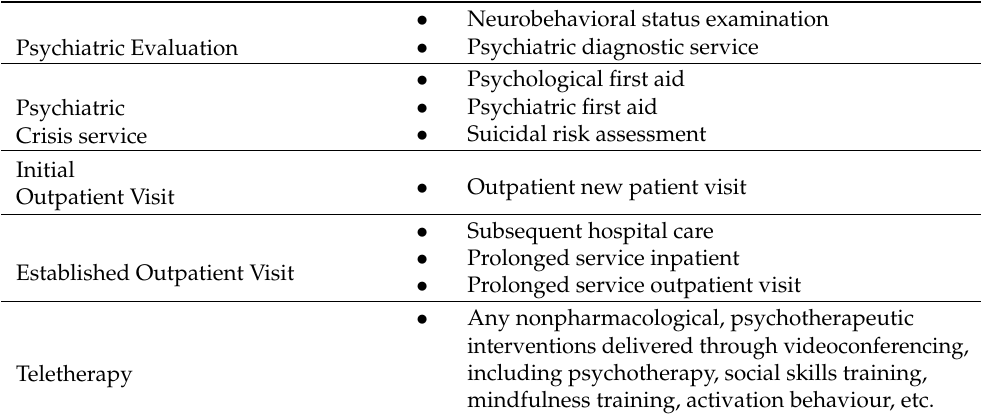
Table 1. Psychiatric services delivered by TeleMental